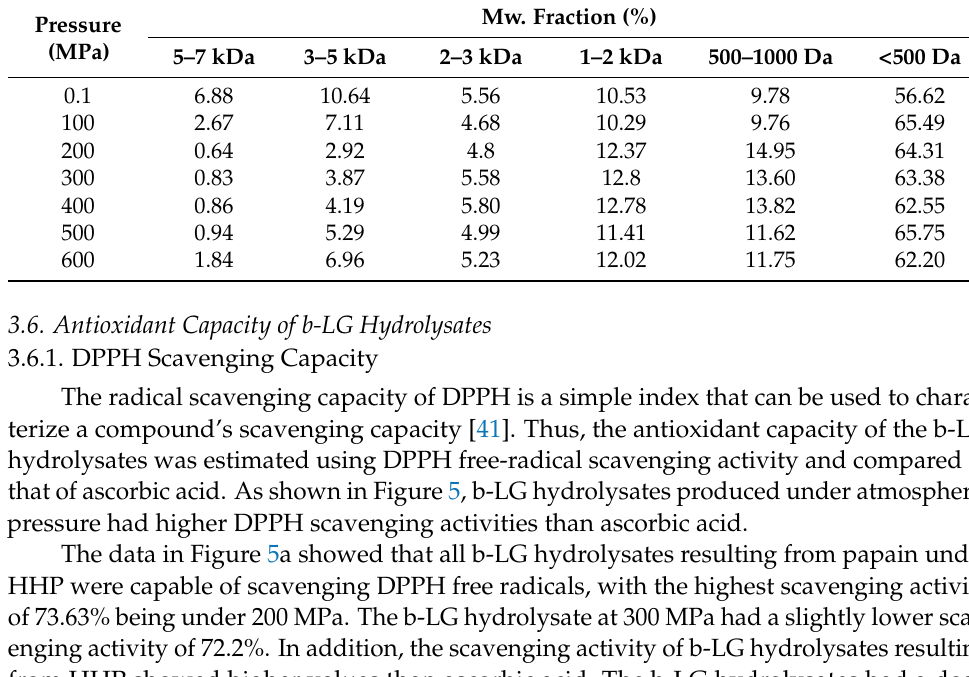
Table 1. Molecular weight (Mw.) profile of b-LG hydrolysates under different pressures.